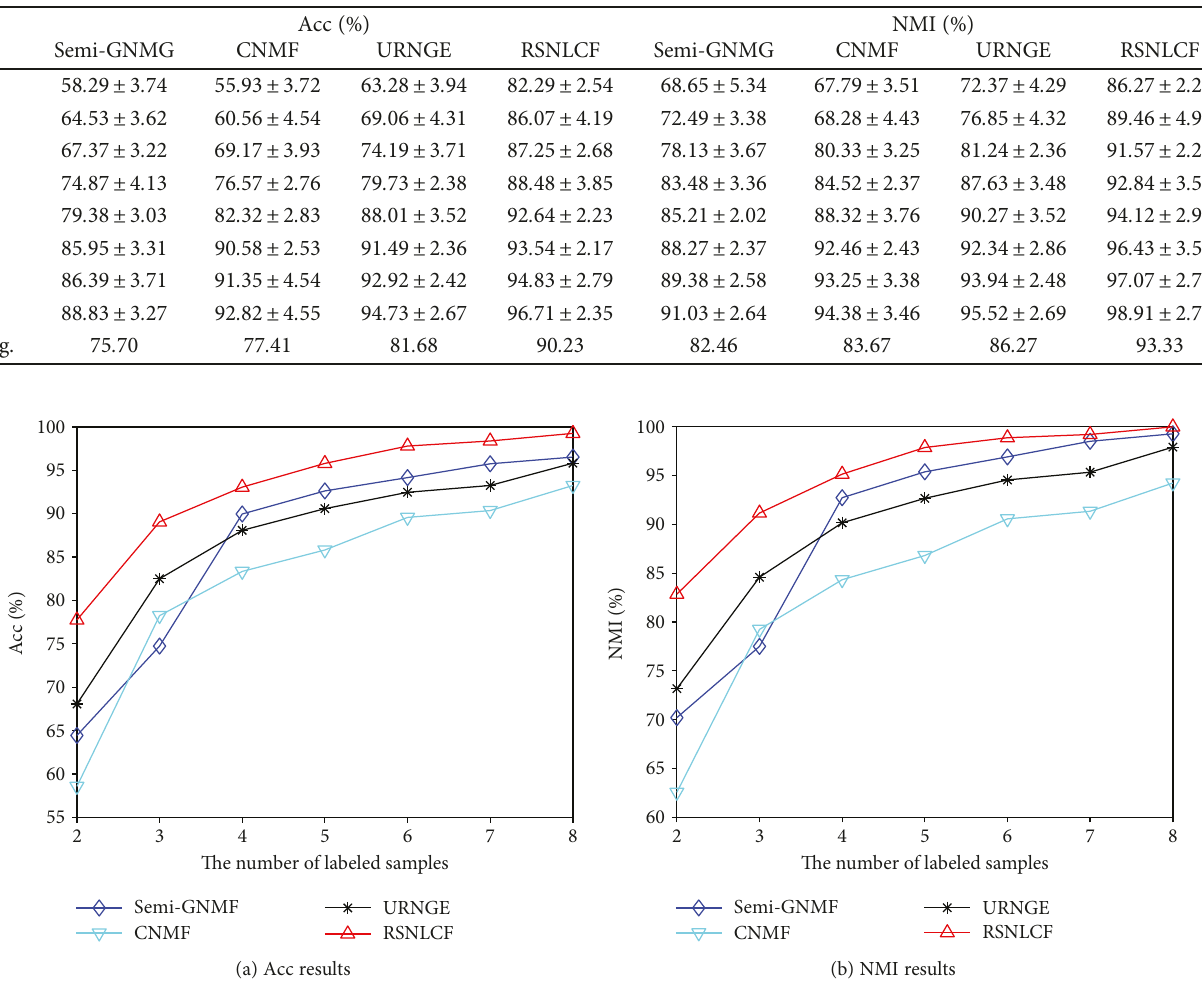
Figure 6: Clustering Acc and NMI curves of the compared methods under di ff erent numbers of labeled samples for the leukemia dataset.